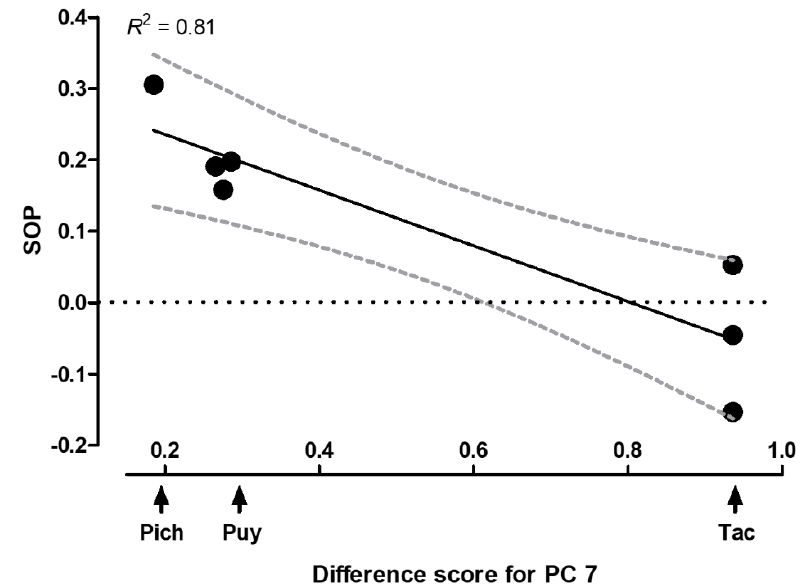
Figure 6. Correlation between females’ SOP for males from their own (not sulfide-adapted) ecotype and the absolute difference between population means in the amount of yellow coloration in males’ fins (PC 7). Shown are data from mate choice tests within and across drainages; for illustration, a linear regression fit and 95% confidence intervals are presented.